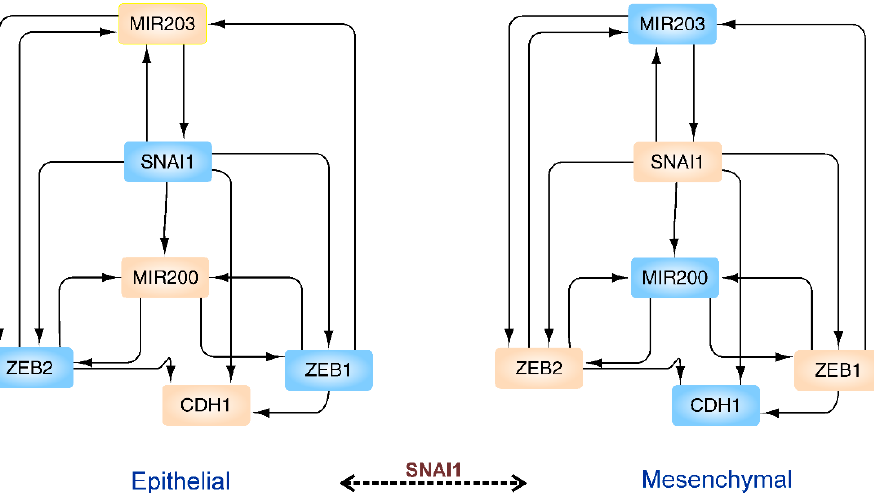
Figure 2. EMT network. Transition of cell phenotype from epithelial to mesenchymal state via a change in transcriptional program is shown. The color of the nodes indicates the different expression (peach = high expression; blue = low expression). The steering kernel for the transition is labelled above the dashed arrow. The network is drawn according to the data by Wu et al. [141].